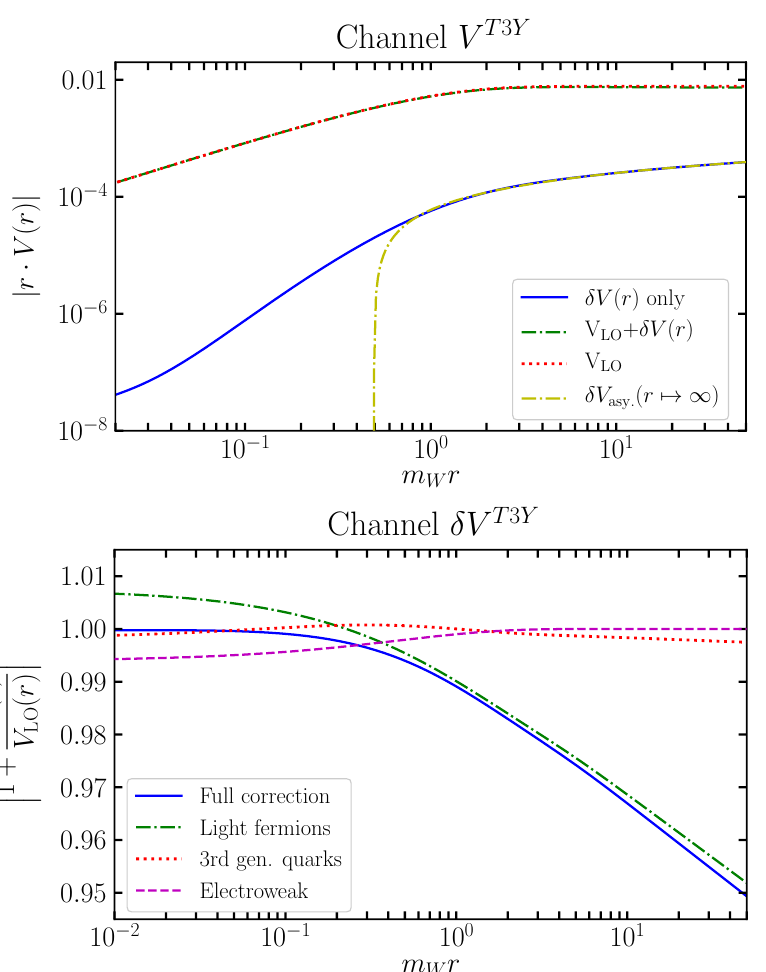
Figure 2 . The NLO correction to the tree potential V T 3 Y . The upper panel shows the modulus tree of the potential | r · V ( r ) | for the LO and NLO potential, the NLO contribution only, and the large-distance asymptotic behaviour. In the lower panel, we show the ratio of the full NLO potential to the LO potential (blue solid) and separately for the three gauge invariant pieces identified in the text (other